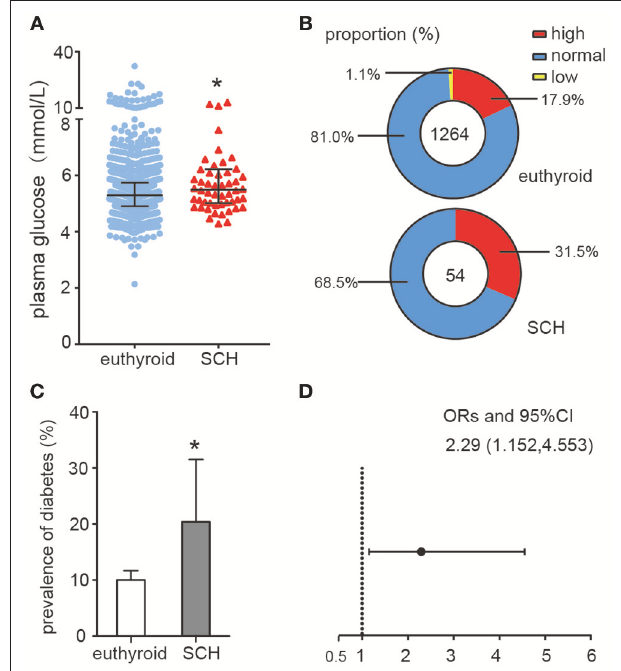
FIGURE 1 | Abnormal Glucose metabolism in SCH patients. (A) Plasma glucose distributions in different group (euthyroid controls and SCH patients), data were expressed as: median (P25, P75). (B) The proportion of the glucose categories in different group. (C) The prevalence of diabetes in different group. The error bars represent the 95% CI of the ratio. (D) The odds ratio of diabetes in different